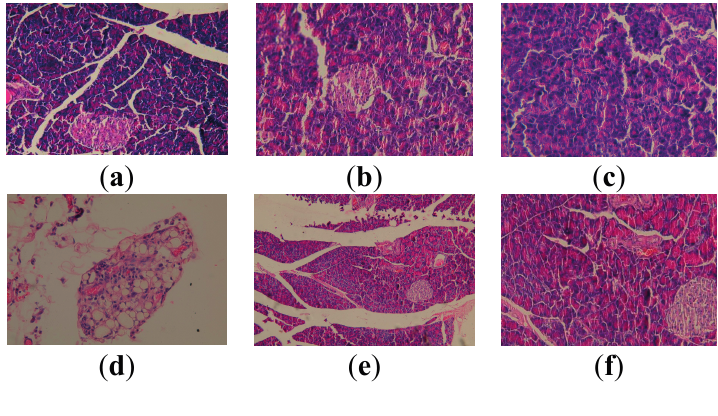
Figure 4. Histopathological evaluation of pancreatic tissue for the experimental groups. ( a ) Normal aspect (group I, control group-standard food) (HEx100); ( b ) Normal aspect (group II, control group-apitherapy diet) (HEx100); ( c ) Normal aspect (group III, control group-untreated) group-apitherapy diet + RJ) (HEx200); ( d ) Liponecrosis (group IV, CCl 4 (HEx400); ( e ) Normal aspect (group V, CCl group + apitherapy diet). (HEx100); 4 ( f ) Normal aspect (group VI, CCl group-apitherapy diet + RJ). 4